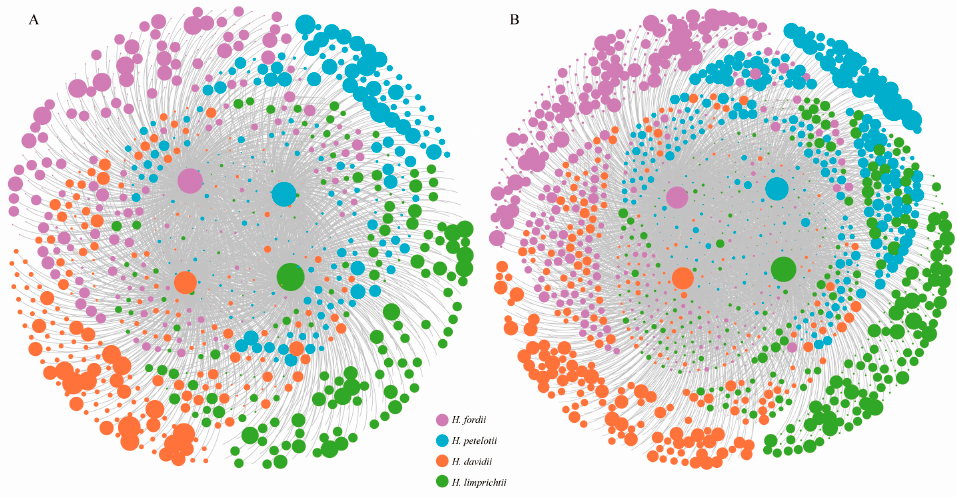
Figure 4. Visualization of the endophytic network. ( A ) ITS3/ITS4OF and ( B ) ITS86F/ITS4. The size of nodes roughly represents the relative abundance of fungal operational taxonomic units.